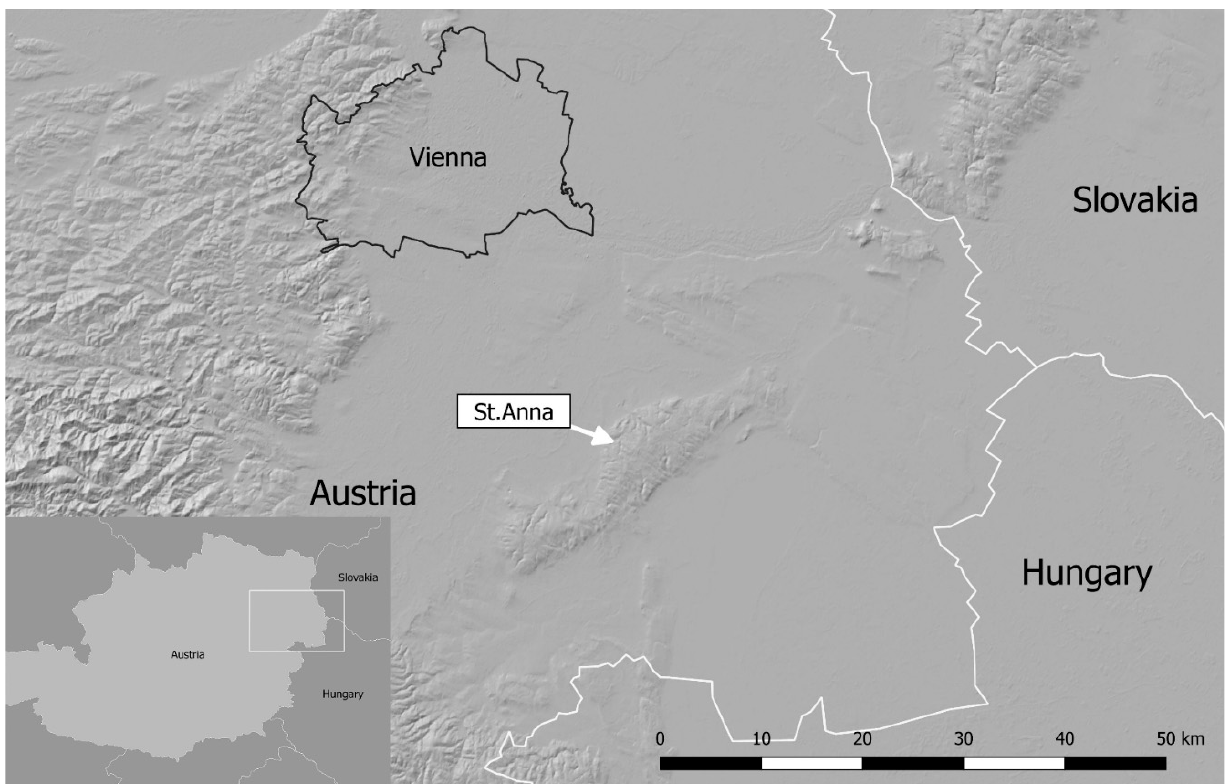
Figure 1. Location of the study area.